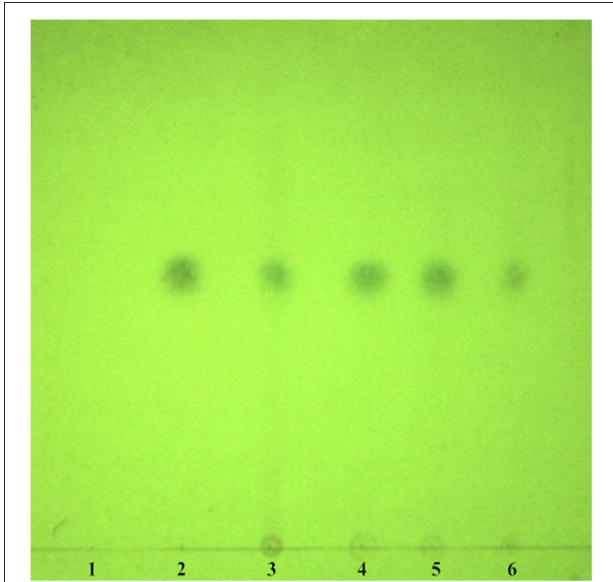
FIGURE 1 | TLC chromatogram for detecting artemisinin in QHP. (1) Negative control. (2) Artemisinin. (3) Standard Chinese herbal medicine. (4-6) Samples of QHP.